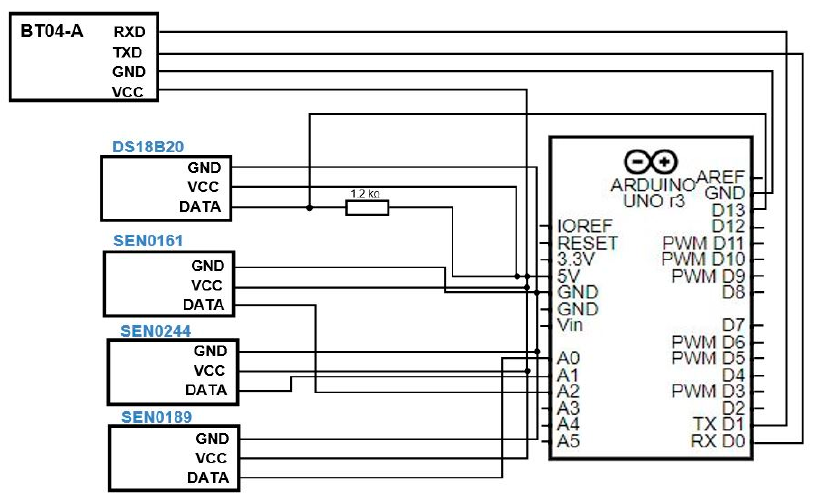
Figure 3. The hardware architecture of the water status project. Table 2. Components prices for a low-cost system